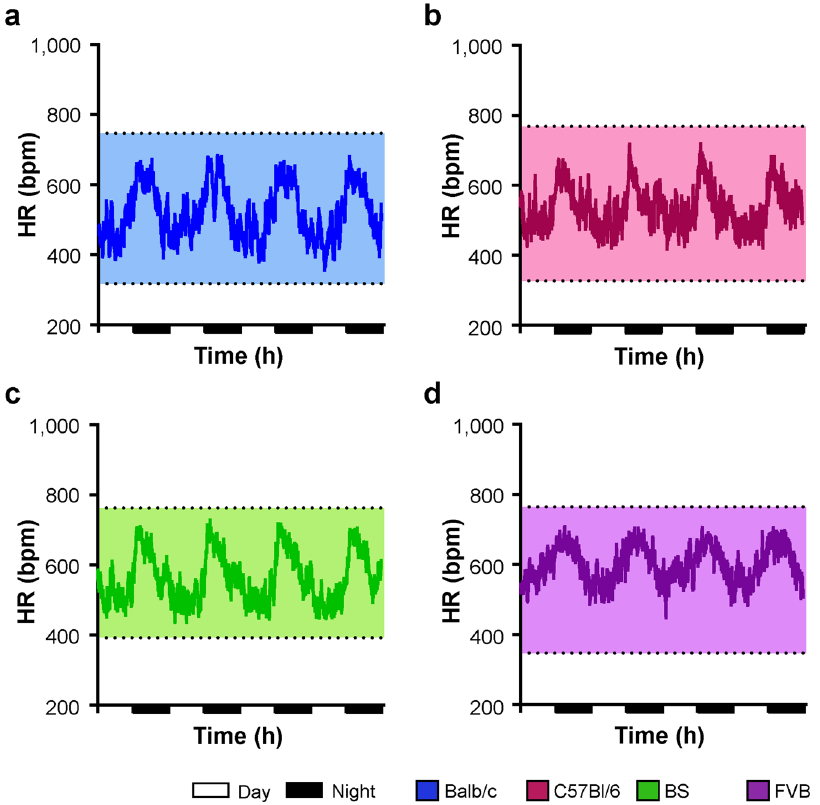
Figure 2. Heart rate regulation under baseline conditions. HR over 96 hours in ( a ) Balb/c, ( b ) C57Bl/6 mice, ( c ) BS mice and ( d ) FVB mice. For means of clarity, only mean values of each group are depicted. Upper and lower lines denote maximal and minimal HRs of each group. Day: 7AM-7PM, Night: 7PM-7AM. Balb/c n = 6, C57Bl/6 n = 6, BS n = 6, FVB n = 5.